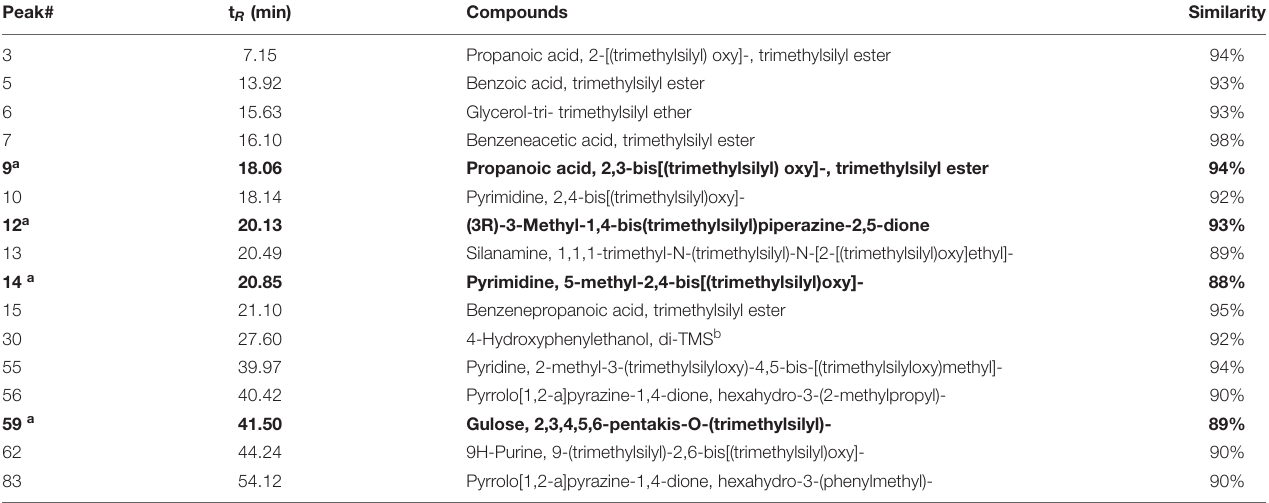
TABLE 2 | Identified compounds by GC-MS presented in S. mutans fraction (SM-F1). Peak# t R (min) Compounds Similarity